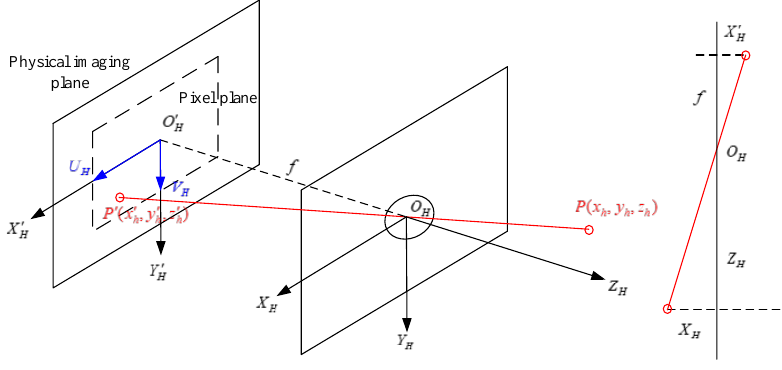
Figure 4. The pinhole photo picturing model.